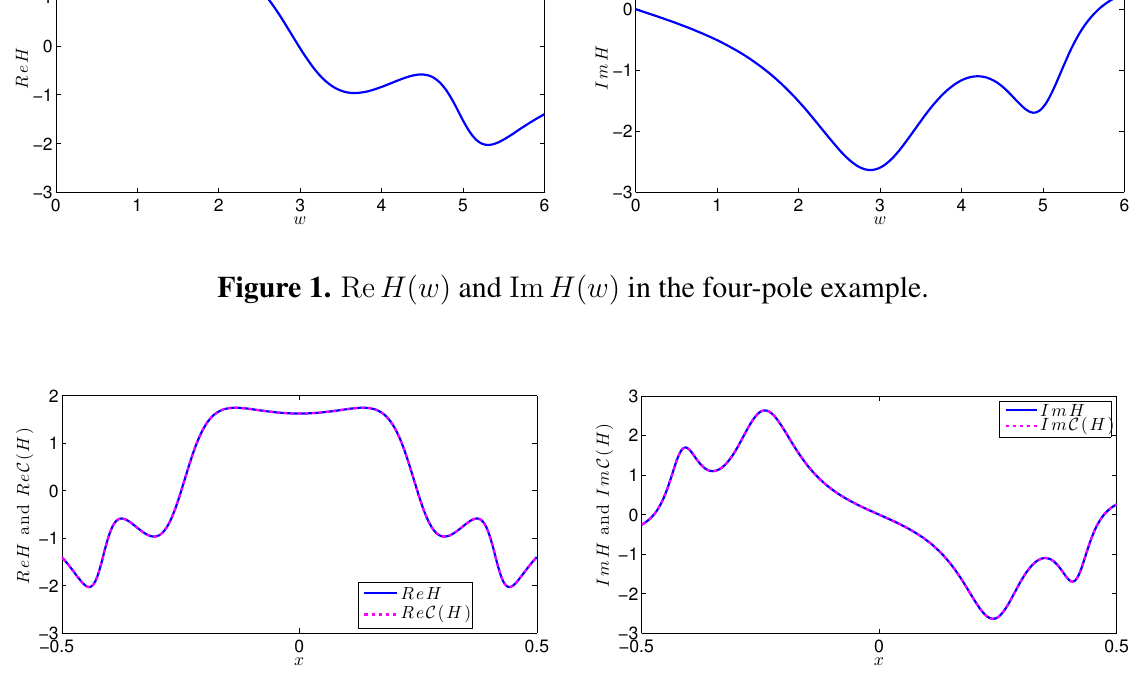
Figure 2. Re H ( x ) and Im H ( x ) of the rescaled and reflected by symmetry transfer function H ( x ) in the four-pole example together with their causal Fourier continuations Re C ( H ) and Im C ( H ) , respectively, with M = 300 Fourier